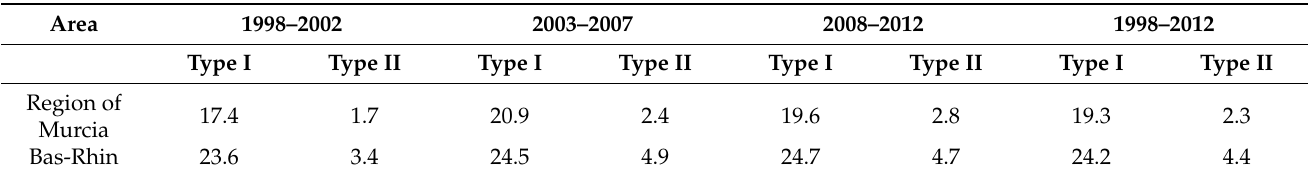
Table 3. Age-adjusted incidence rates/100,000 person-years (2013 European Standard Population) for type I and II endometrial carcinoma, by period in the Region of Murcia and Bas-Rhin area, 1998–2012 period.